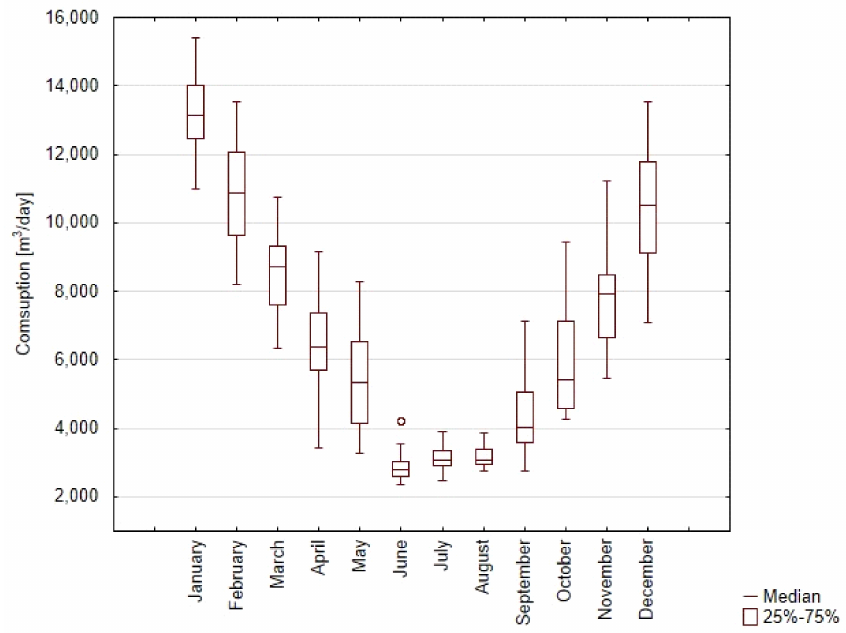
Figure 4. Average gas consumption in individual months ( x -axis: natural gas consumption in m 3 /day (24